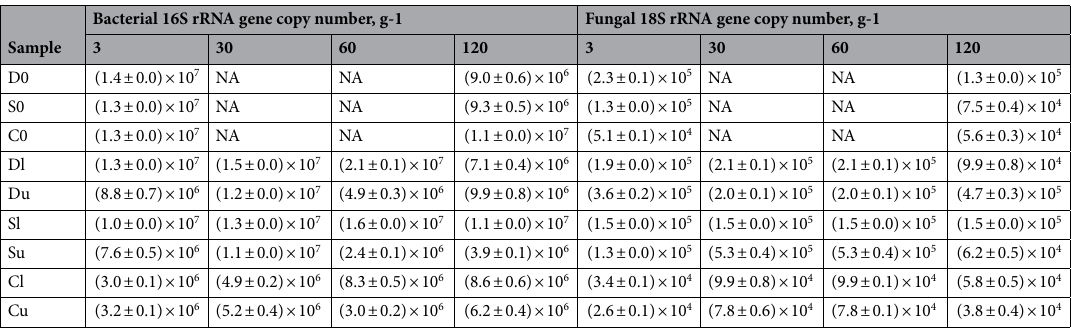
Table 1. Copy numbers of bacterial 16S rRNA and fungal 18S rRNA genes in unpolluted and oil-polluted soils.